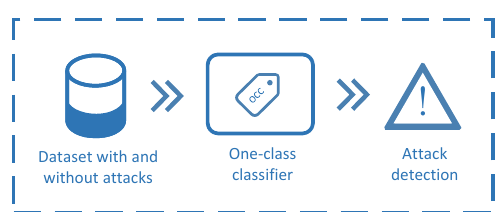
Figure 2. One-class classifier implementation.